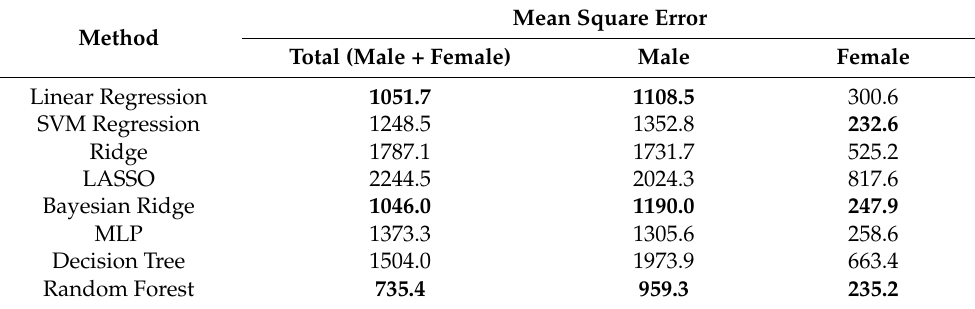
Table 2. Show the mean square